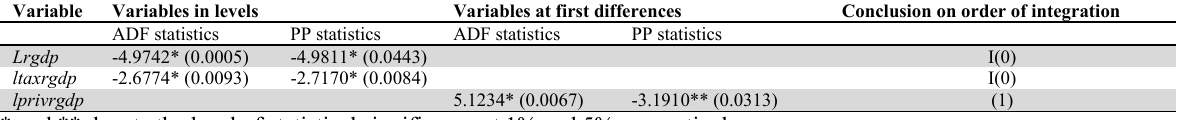
The Augmented Dickey Fuller and Phillips-Perron Tests Results Variable